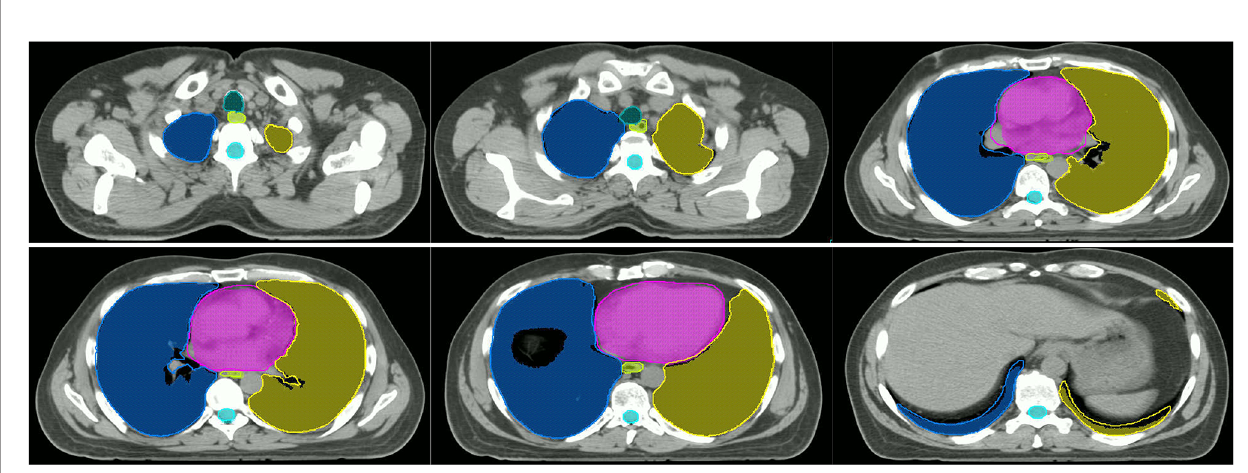
FIGURE 4 | Comparison of manual and automatic segmentation of the OARs based on the proposed model (Color wash: the manual segmentation contour; line: the automatic segmentation contour).